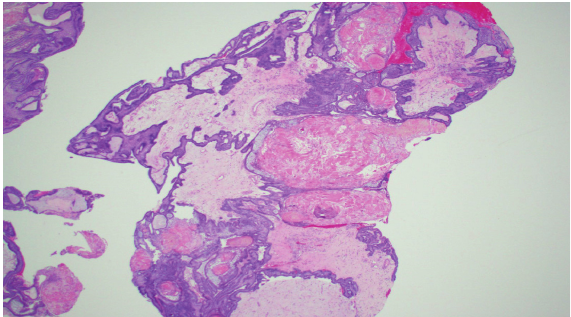
Figure 5: This section reveals stellate reticulum in the middle of the image with whorls of keratin diffusely throughout consistent with the adamantinomatous